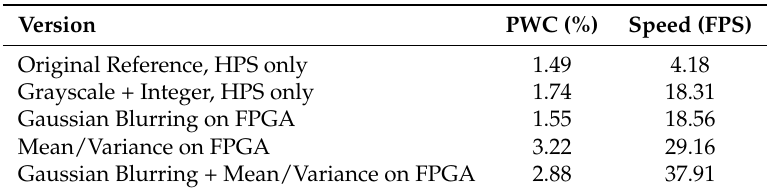
Table 3. Hardware Acceleration